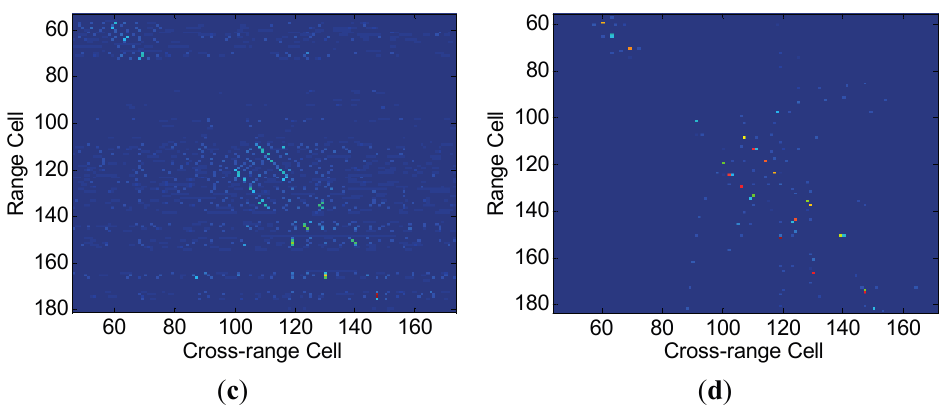
Figure 5. ( a ) ISAR image via IFFT-IFFT method; ( b ) ISAR image via existing IFFT-SR